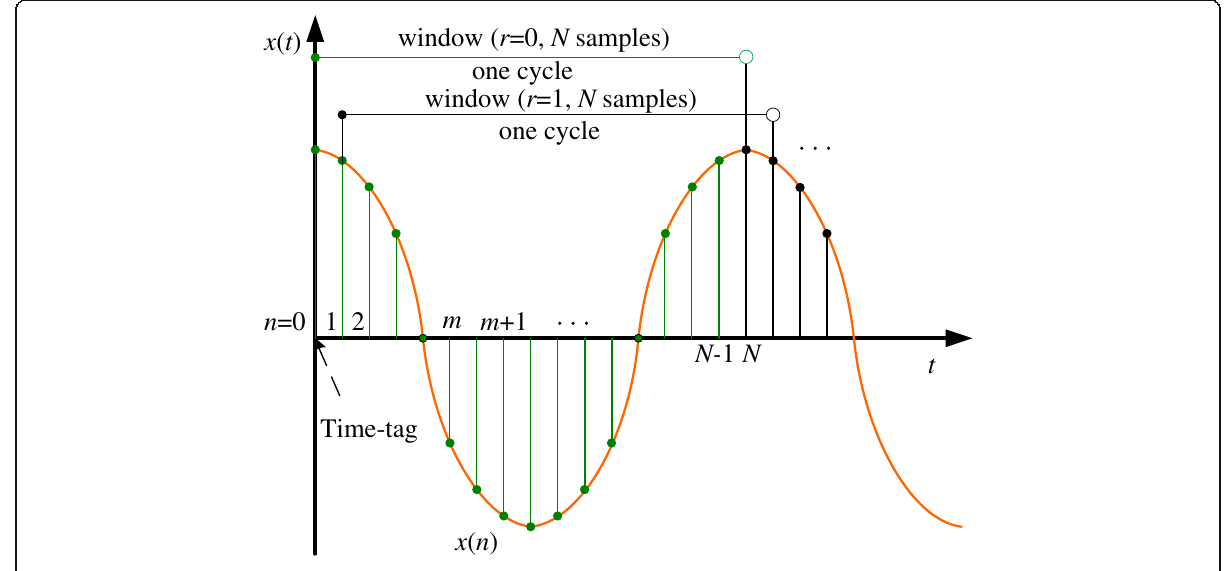
Fig. 4 Shifting windows of cosine waveform with time-tag at time t = 0